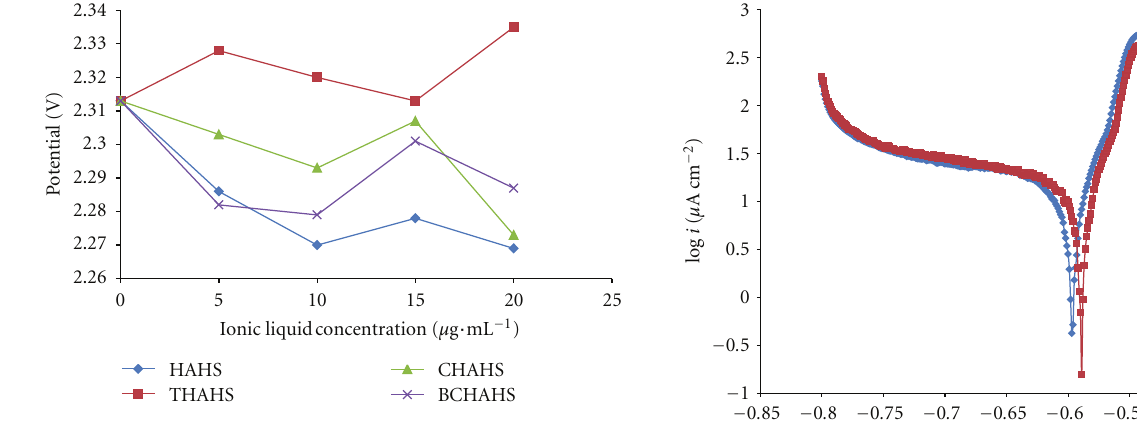
Figure 1: Oxygen oxidation potential by scan rate 50.0 mVs − 1 in 4.0moldm − 3 H 2 SO 4 in various concentrations of ILs at the current density in 4.0 mAcm − 2 at the anodic scan.